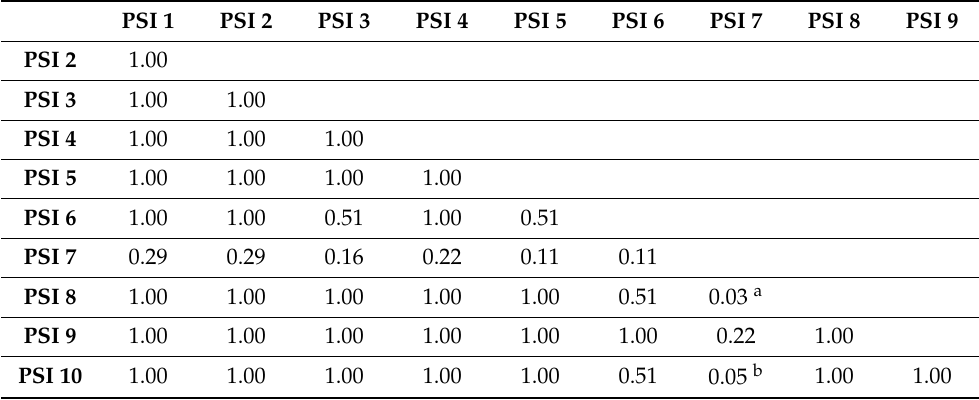
Table 2. Dimensional repeatability assessment of material extrusion 3D-printed PEEK patient-specific cranial implants concerning p -values of the Tukey–Kramer post hoc